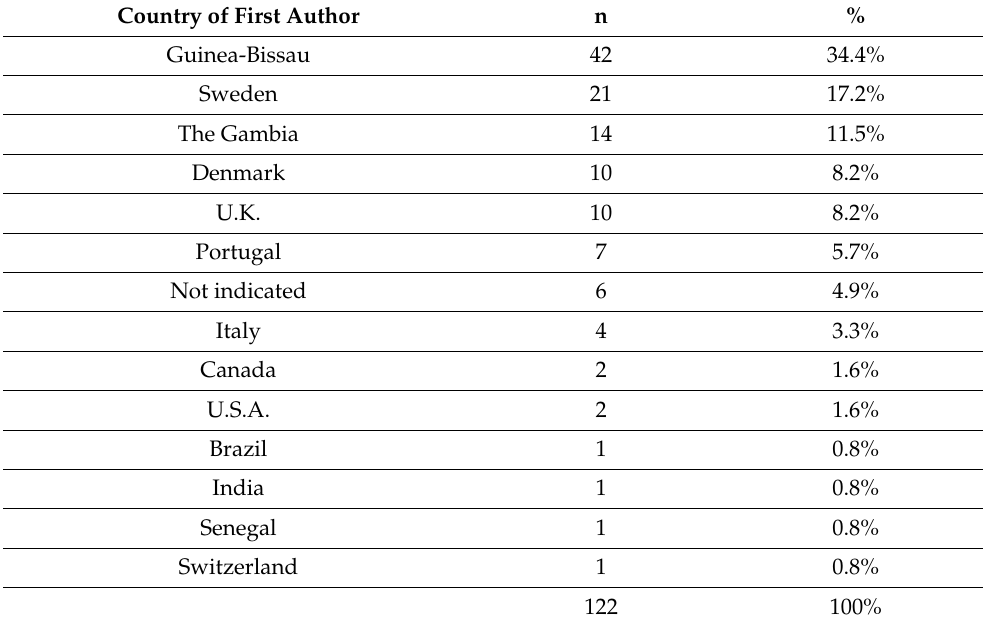
Table 3. Country affiliation of first author (n =